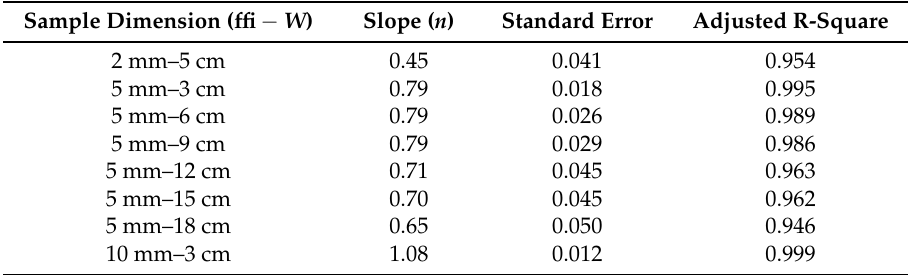
Table 2. Fitted parameters corresponding to Figure 7.